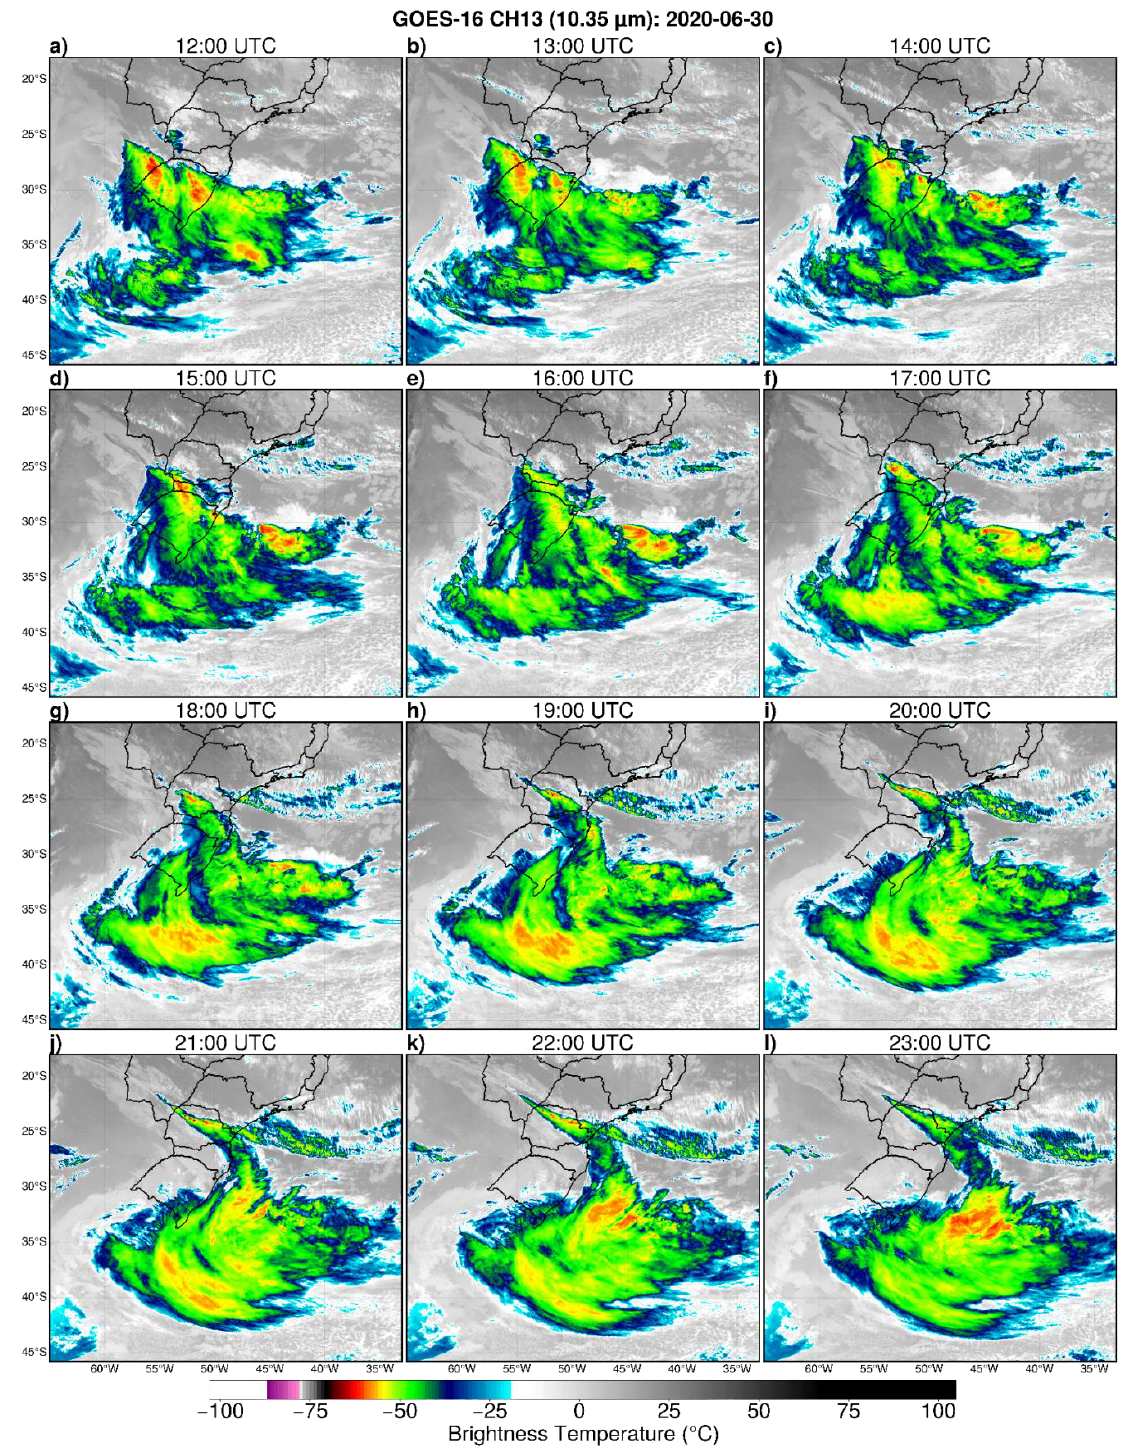
Figure 11. ( a – l ) Brightness temperature (°C) images f rom the infrared channel (CH13, 10.35 μm) provided by GOES – 16 satellite from 1200 to 2300 UTC on 30 June 2020. provided by GOES–16 satellite from 1200 to 2300 UTC on 30 June